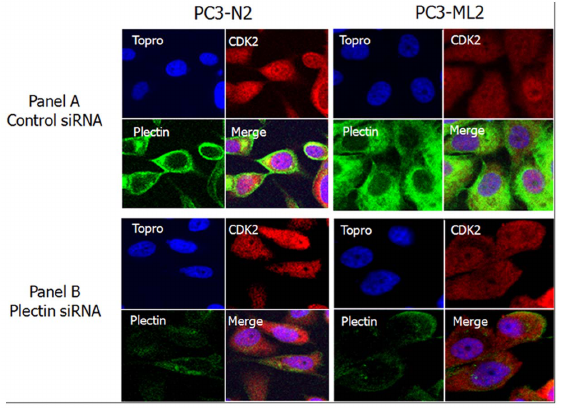
Figure 3. Confocal microscopy of PC3-N2 and PC3-ML2 cells for visualization of Plectin and CDK2. Cells were treated with control siRNA or Plectin gene specific siRNA for 3 days and then fixed, incubated with rabbit polyclonal anti-plectin and mouse monoclonal anti-CDK2 primary antibodies before "staining" with Alexa Fluor conjugated donkey anti-rabbit secondary antibodies (green), goat anti-mouse secondary antibodies (red) and the nuclear stain TOPRO (blue). Panel A shows the images for control siRNA transfected cells and Panel B shows the Plectin siRNA transfected cells.